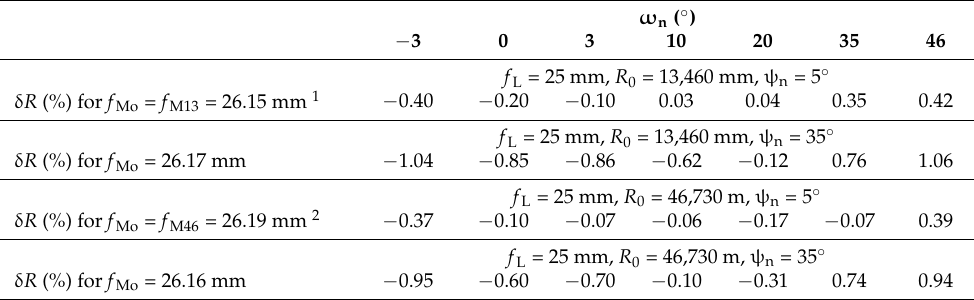
Table 8. Distance percentage errors δ R (%) for the optimal model focal length.